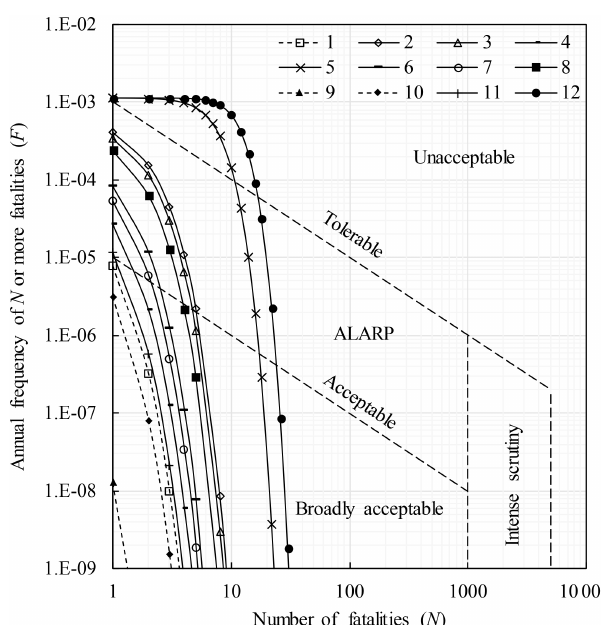
Figure 11. Estimated annual frequency of N or more people being hit by the landslide studied in this paper (tolerable and acceptable F – N curves are those specified by the GEO, 1998). The numbers on the x axis refer to the following vehicle types: 1 – private buses,